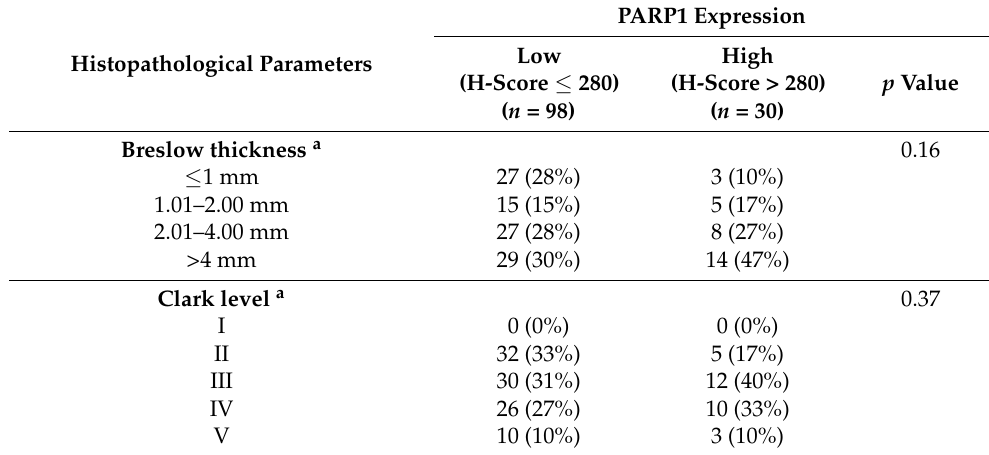
Table 3. Correlations between PARP1 expression and histopathological parameters of primary tumors in cutaneous melanoma